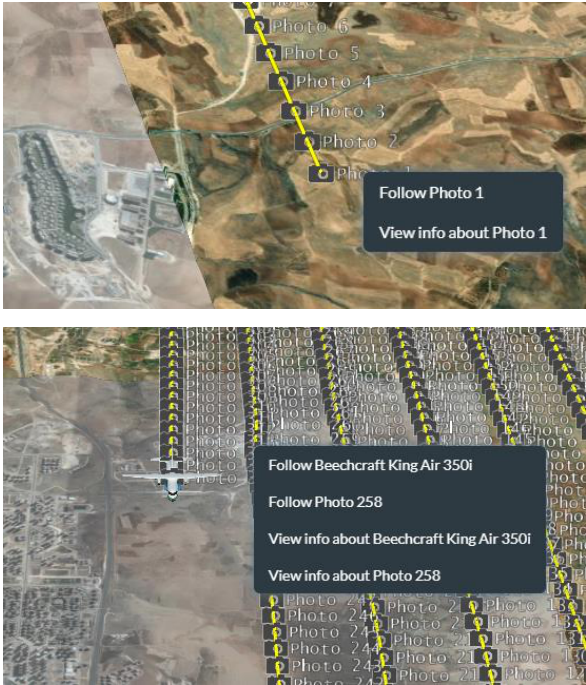
Figure 8 . Examples on the attribute information retrieval on the